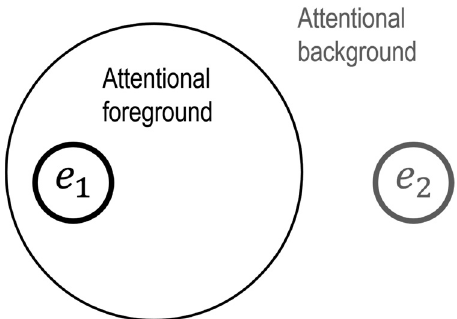
Figure 1: Segregation between the attentional foreground and the attentional background. e 1 denotes an experience as of an object that is attended to, while e 2 denotes an experience as of an object that is not attended to. Is there an experiential connection between e 1 and e 2